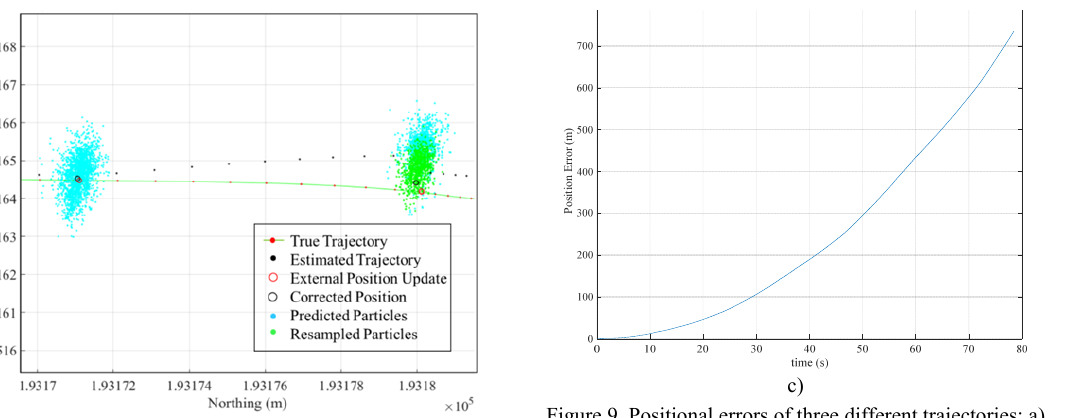
Figure 8. A section of the computed trajectory by the particle filtering method compared to the true trajectory